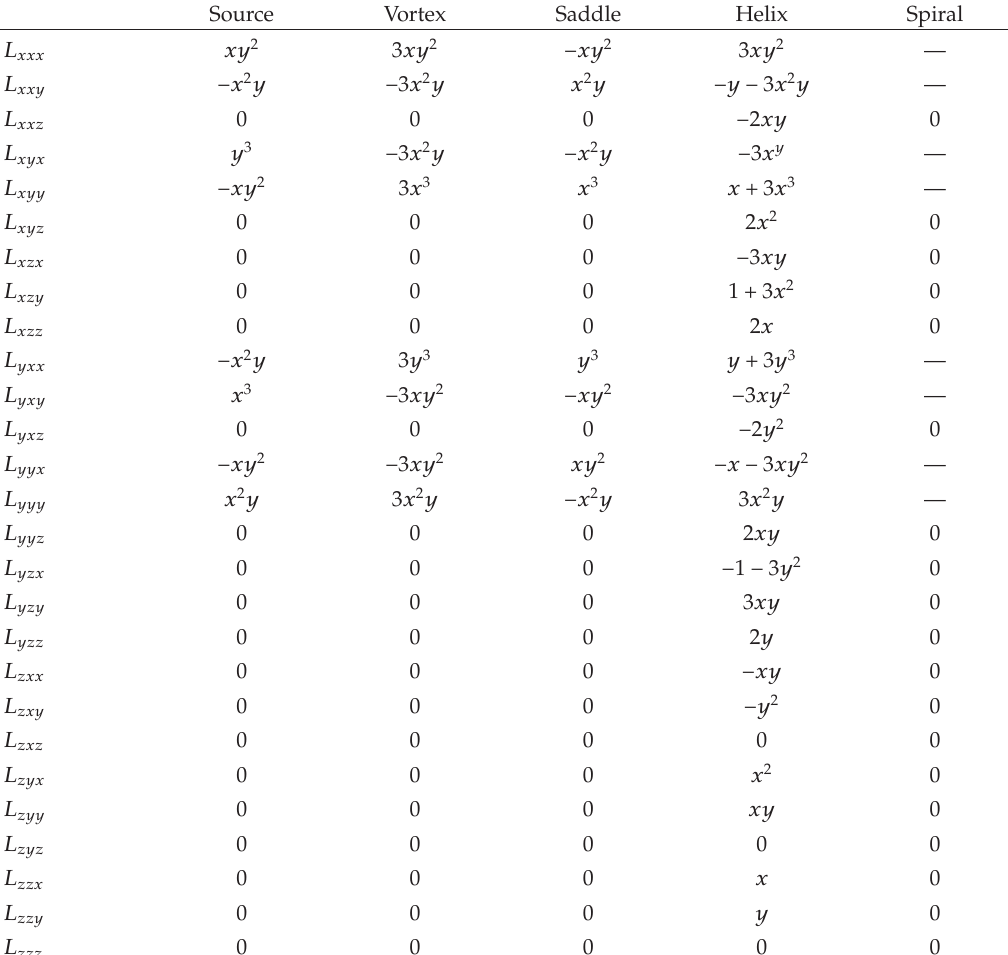
Table 3: Lamb tensor